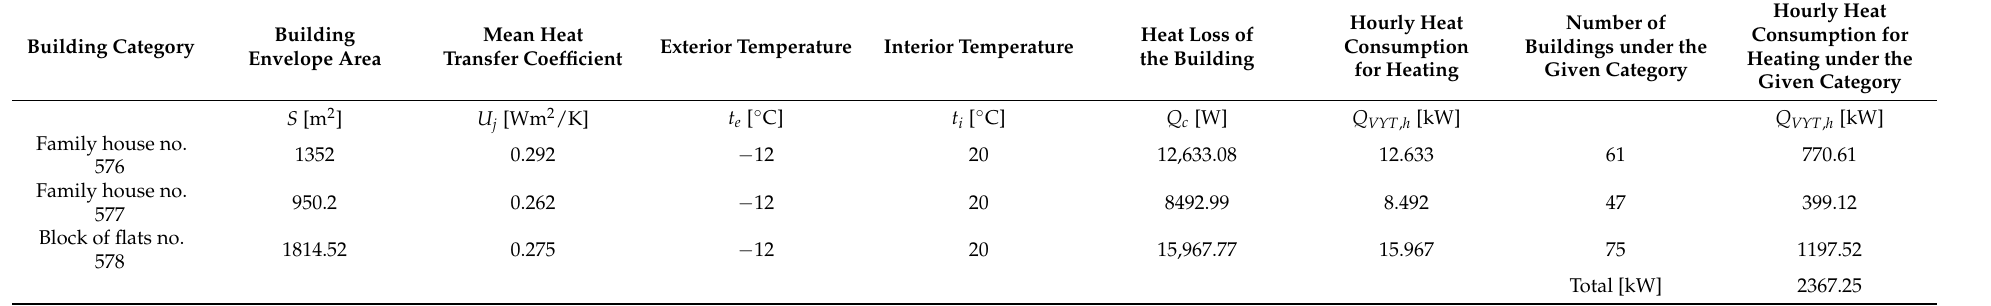
Table 3. Hourly Heat Consumption for Heating After